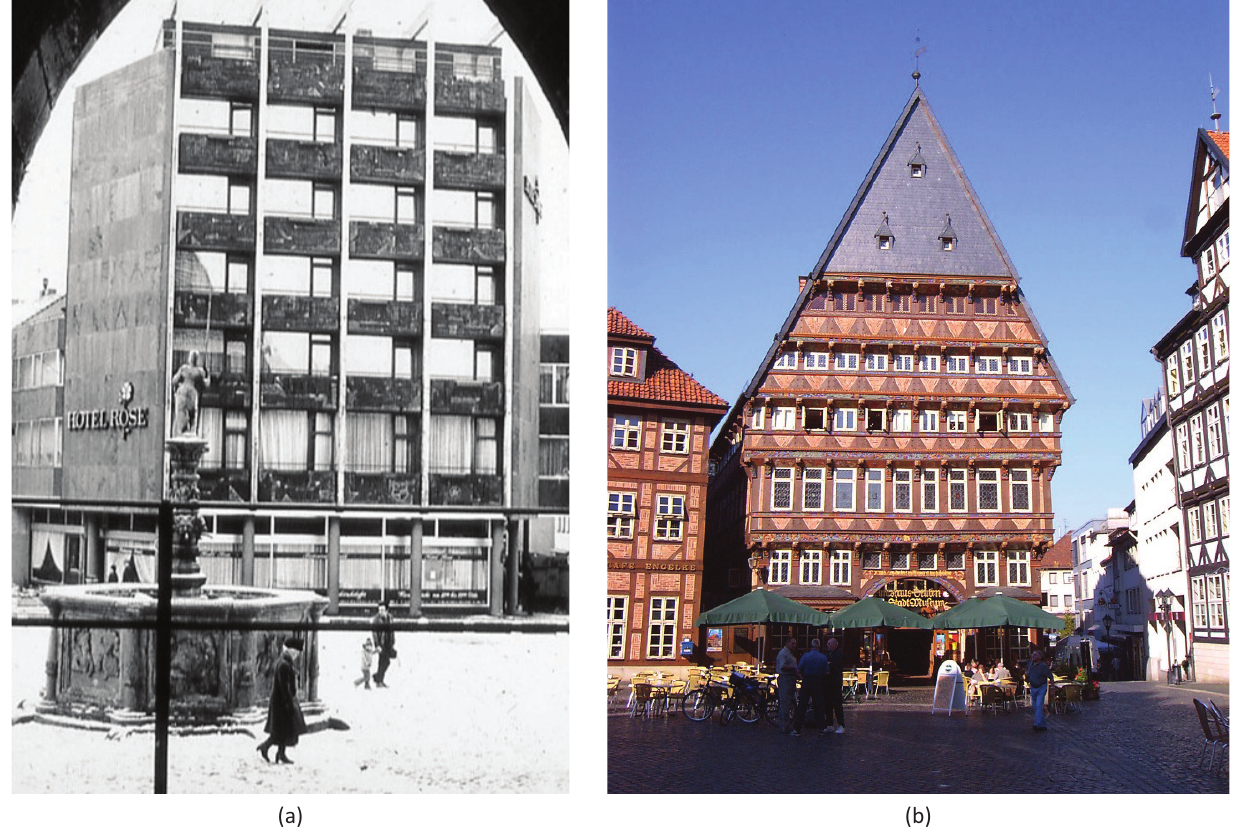
Figure 2. Hotel, 1962 (a) and reconstructed Knochenhaueramtshaus (b). Sources: (a) Förderverein Berliner Schloss e.V. (n.d.) and (b) Wikimedia Commons (2005).